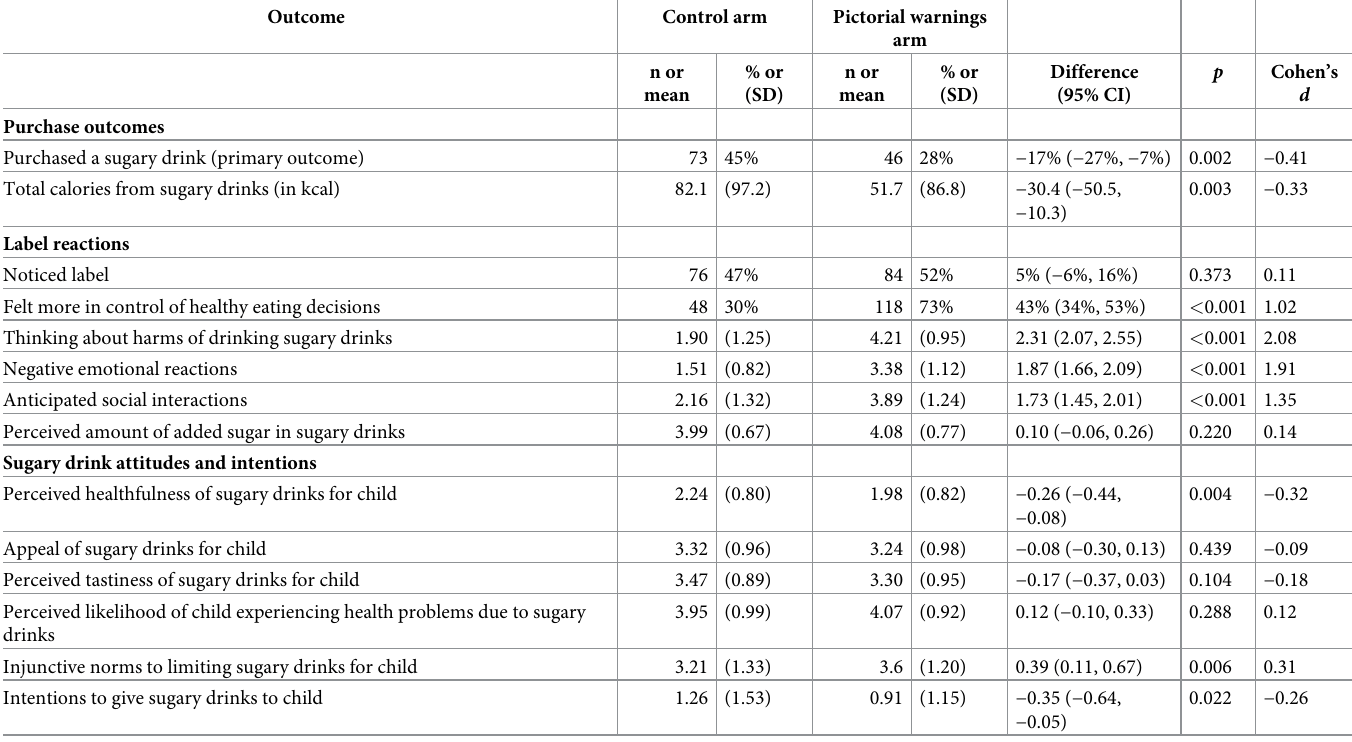
Table 2. Impact of pictorial warnings on sugary drink purchases and secondary